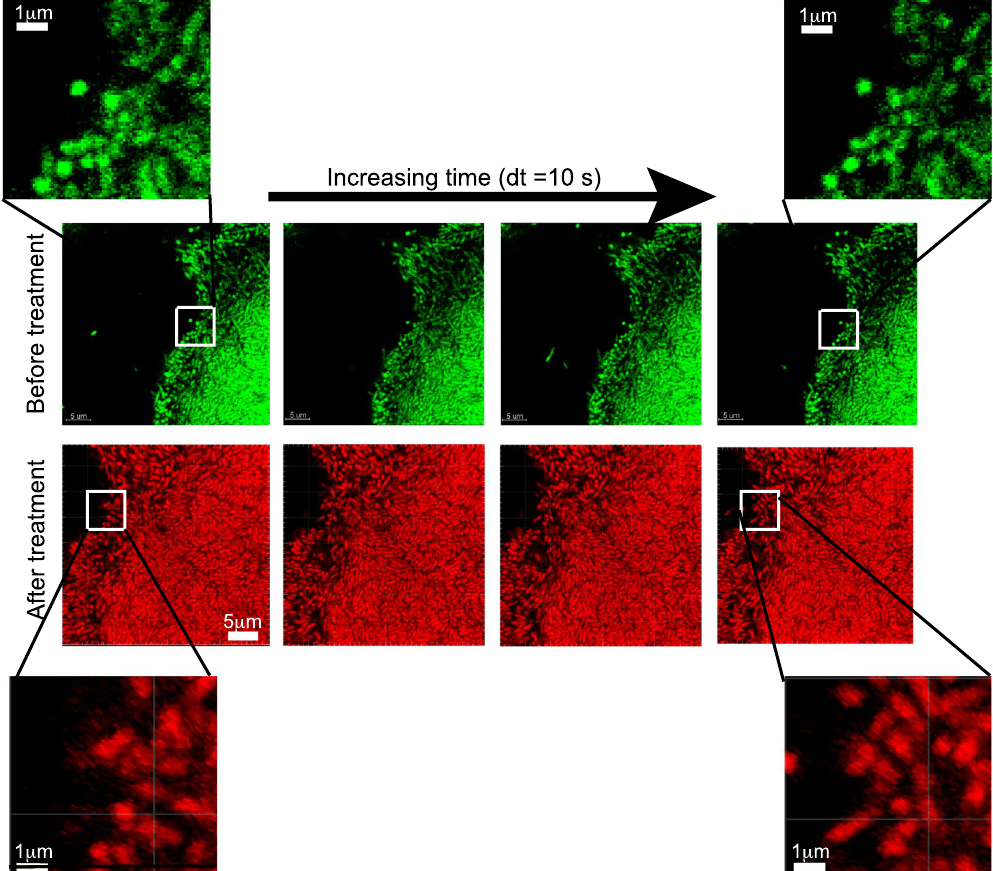
the individual bacteria within this time span. ( B ) When the bacteria are killed, there is a rearrangement in the bacterial cells at the edge of the colony within a period of 40 s. Shedding of the bacteria is also shown in Supplementary Movie